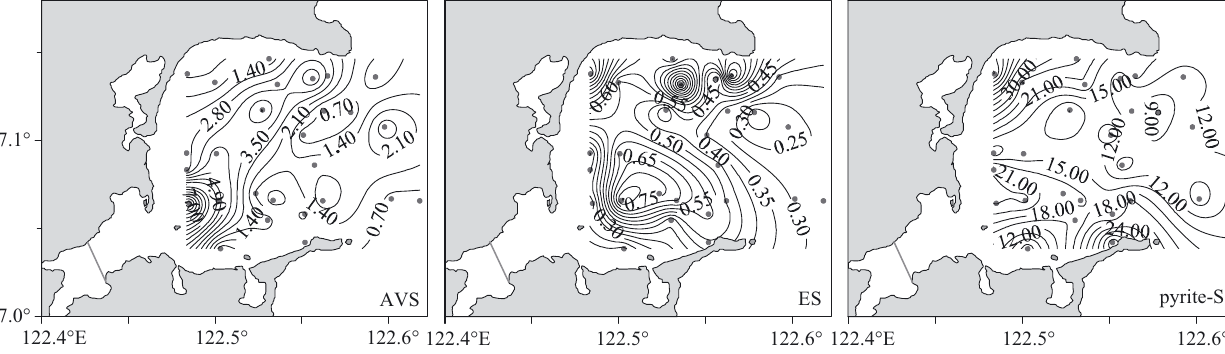
Fig. 7. Horizontal distributions of acid-volative sulfide (AVS), elemental sulfur (ES), and pyrite-S (µmol g −1 ) in surface sediments of Sanggou